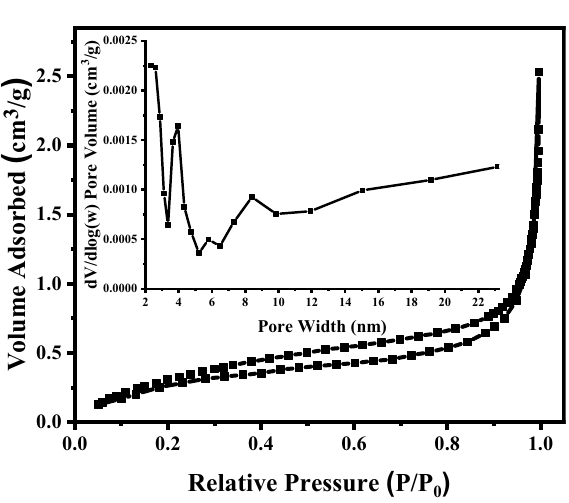
Figure 6. Schematic of the proposed fly ash surfaces coated with PEDOT: PSS.